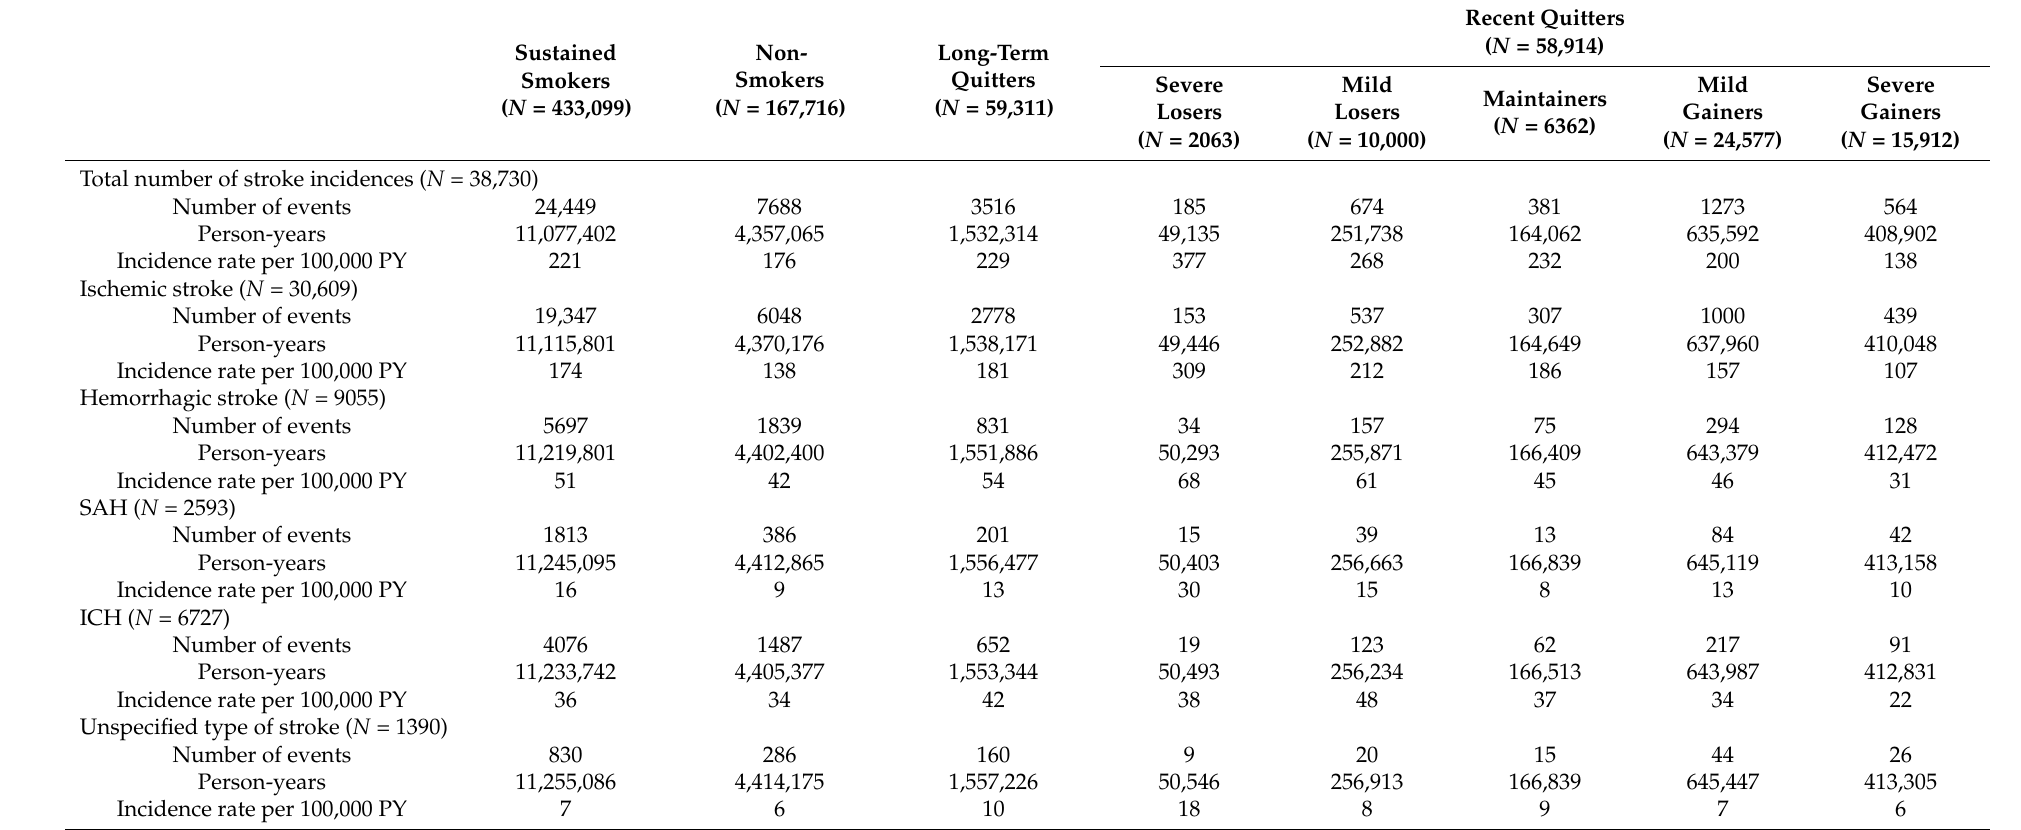
Table 4. Incidence rates of stroke and its subtypes, according to smoking cessation and weight change in Korean